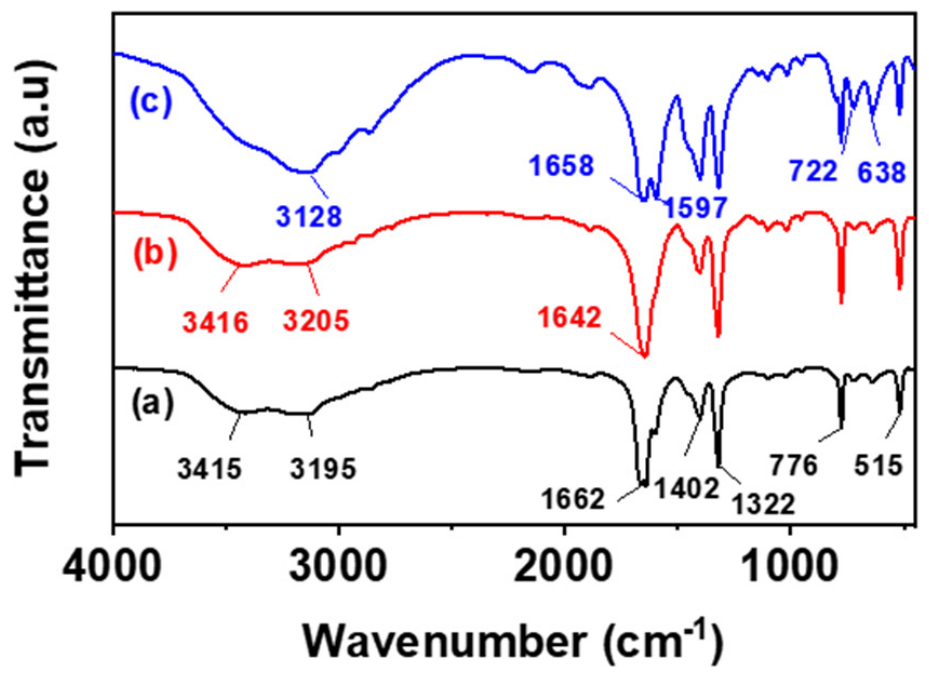
Figure 4. FTIR spectroscopy of pectin extracted from H. ovalis ( a ), T. hemprichii ( b ), and E. acoroides ( c ).